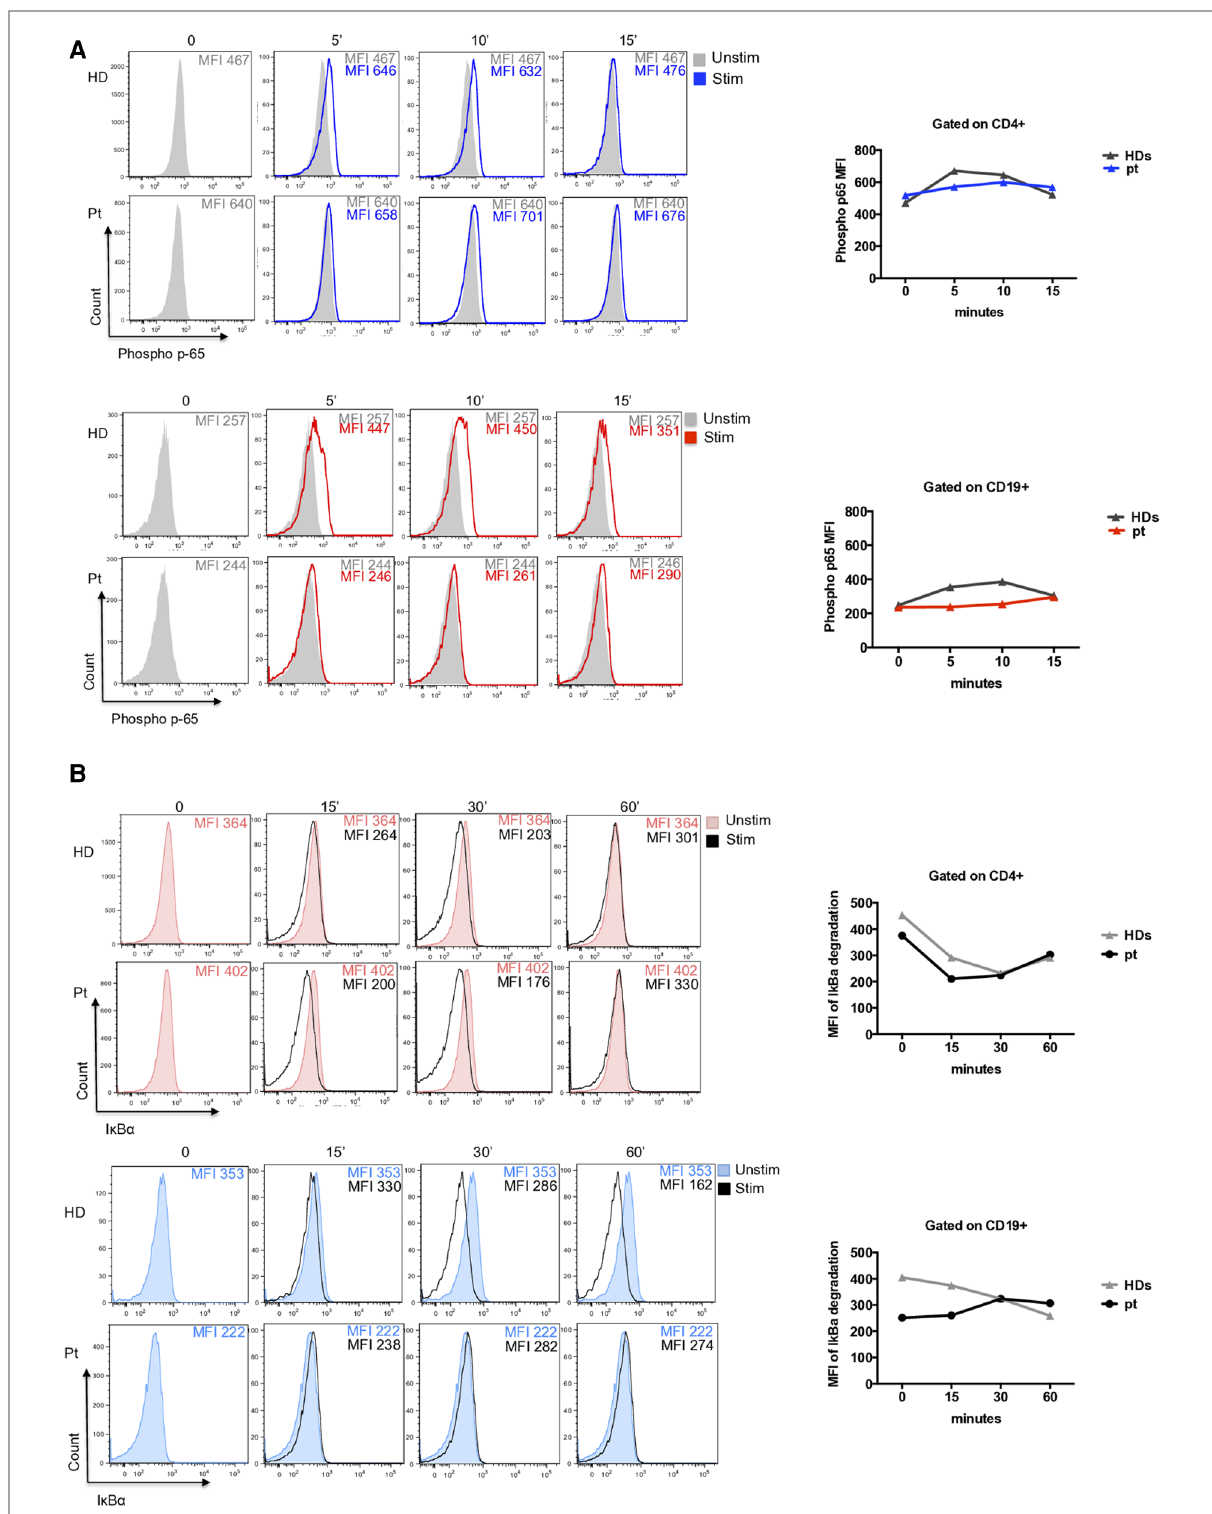
FIGURE 2 ( A ) Representative histograms of phospho-p65 expression in CD4+ T cells (blue histograms) and CD19+ B cells (red histograms) from patient and unrelated control. Graphs show the mean of two independent experiments. ( B ) Representative histograms of I κ B α degradation (a reduction of IkBa expression is showed due to degradation) in CD4+ T cells (red fi lled) and CD19+ B cells (blue fi lled) from patient and an unrelated control. Graphs show the mean of two independent